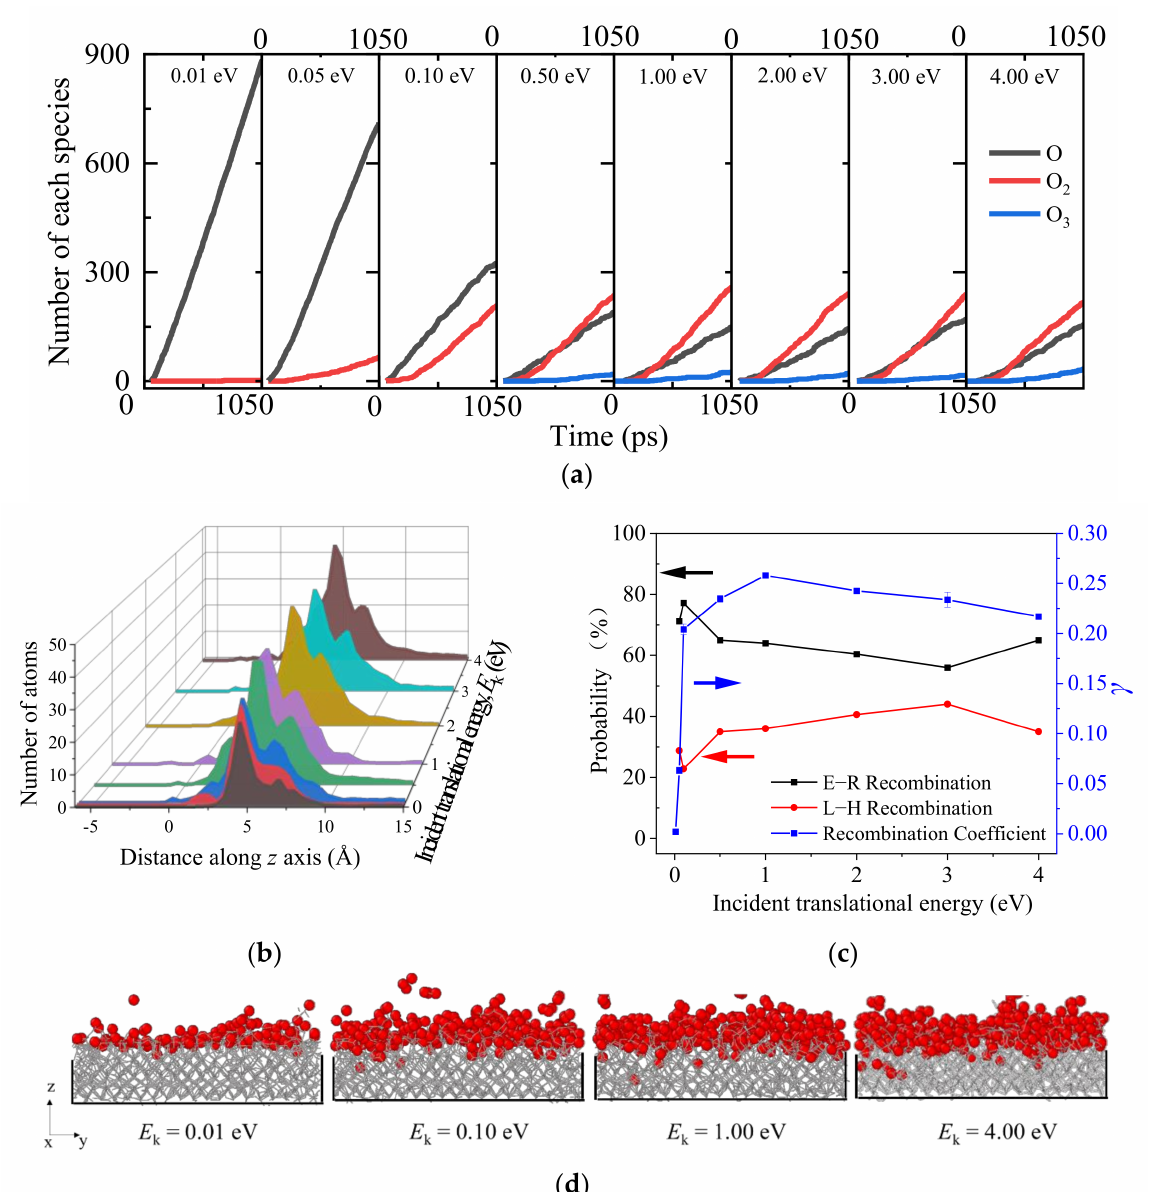
Figure 10. The effect of AO incident translational energy on the flow field, material response, and the silica surface catalysis characteristics by Models 1 and III-10–16. ( a ) The statistics of various species in the gaseous phase during the collisions, ( b ) the incident angle effect on the saturated z-density profiles of oxygen atoms on the silica surface, ( c ) the calculation of surface catalysis recombination coefficient and the detailed recombination mechanism analysis, and ( d ) snapshots for the final AO surface adsorption